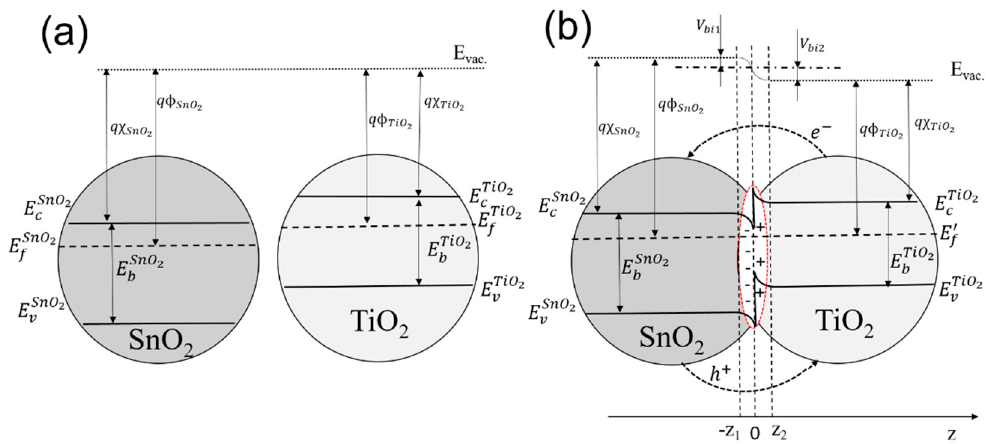
Figure 11. Schematic diagrams of flat energy band approximations of ( a ) SnO 2 and TiO 2 and ( b ) the TiO 2 –SnO 2 heterojunction in vacuum. TiO 2 –SnO 2 heterojunction in vacuum.